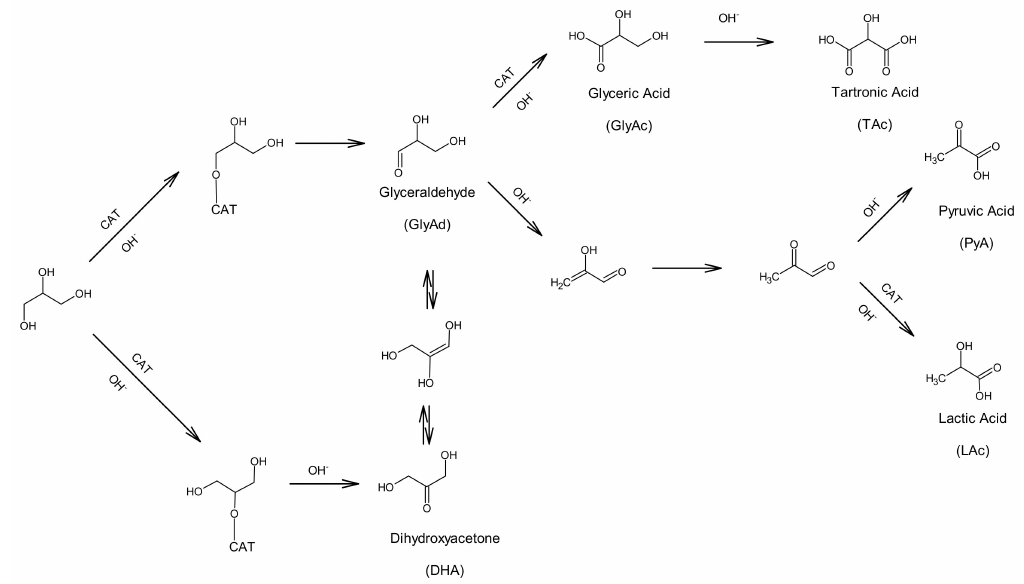
Figure 10. Di ff erent C3 products observed in glycerol selective oxidation under alkaline conditions.